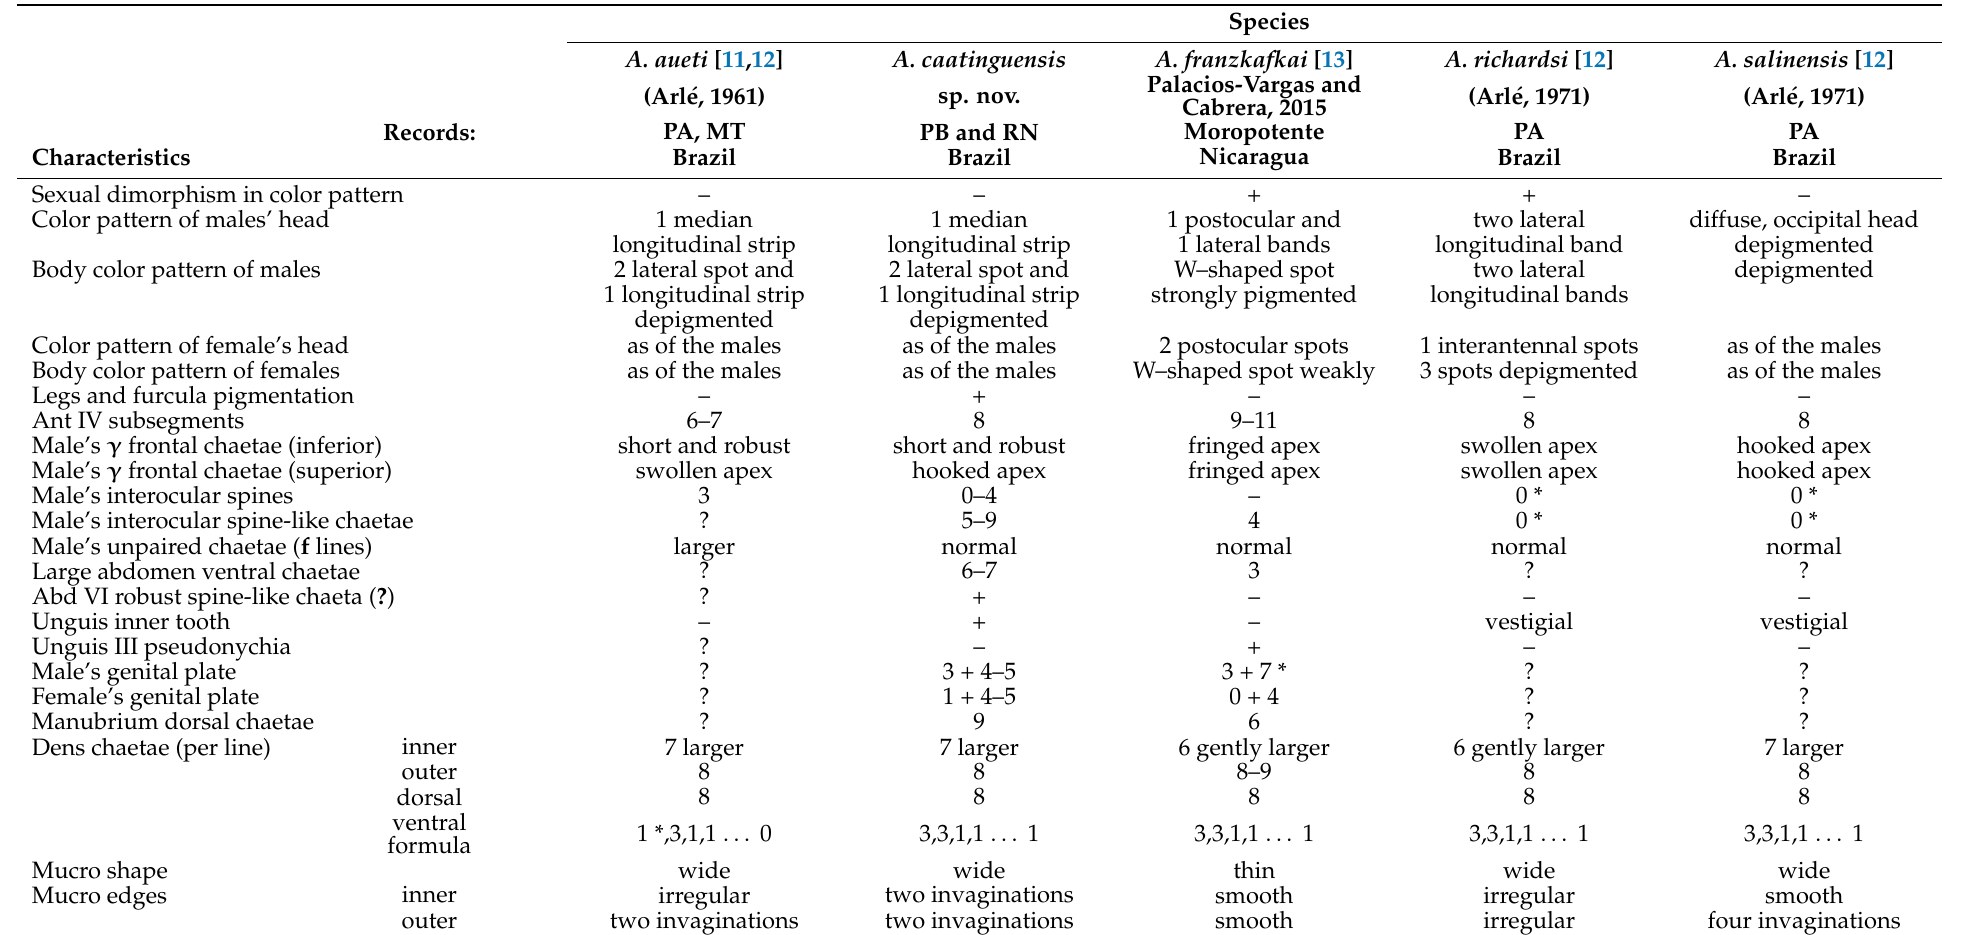
Table 1. Comparison among Arlesminthurus